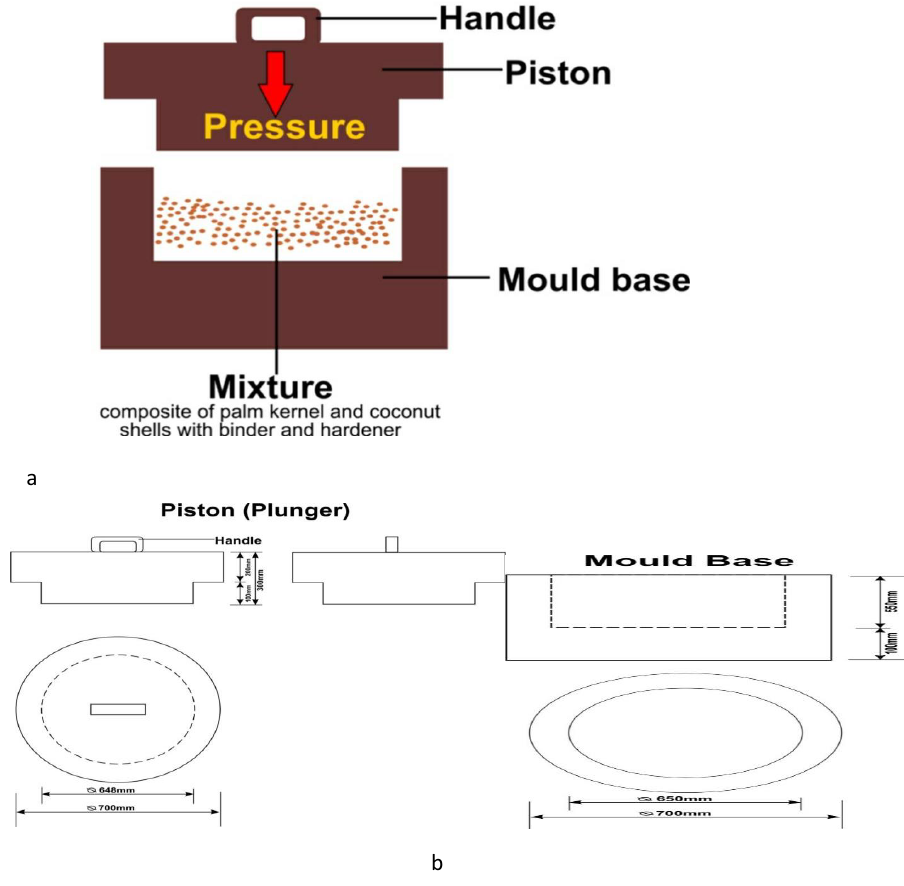
Figure 3: (a) Schematic components of the compression mould (b) Design drawings of piston and mould base, dimensions in mm